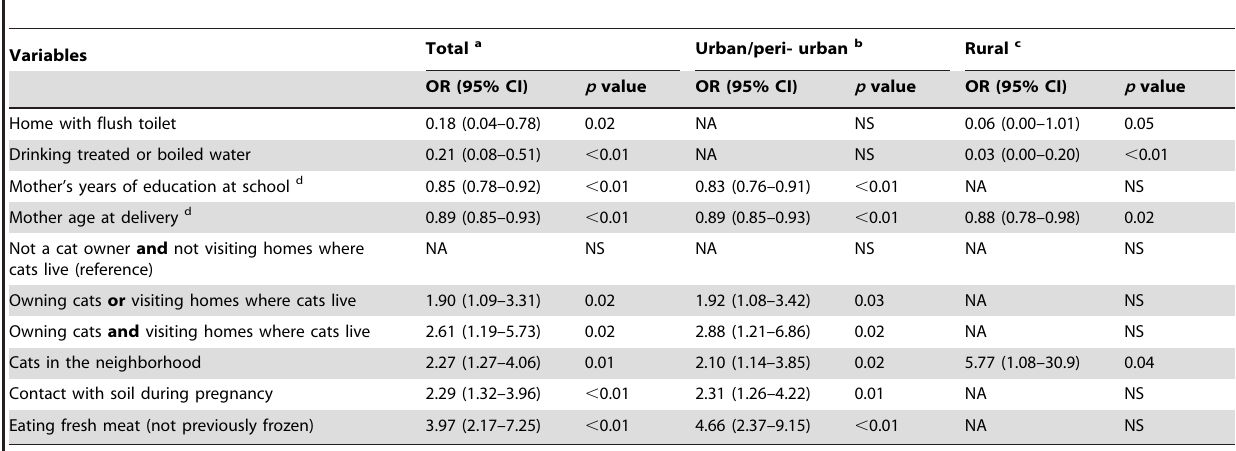
Table 4. Multivariate analysis of the risk factors associated with congenital toxoplasmosis in the State of Minas Gerais.